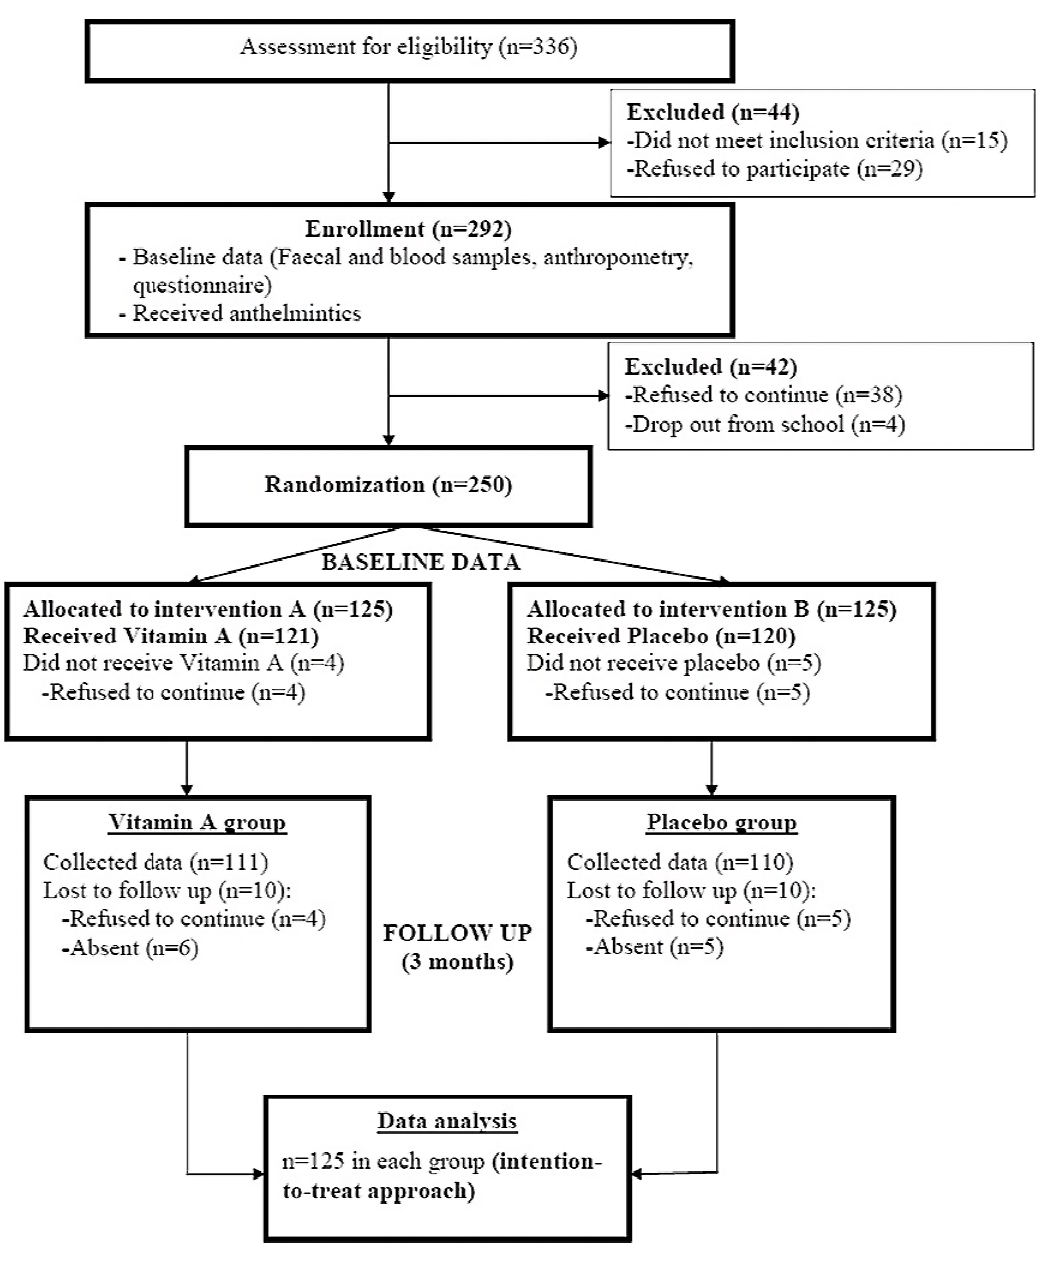
Figure 2. Flow chart of data collection and follow